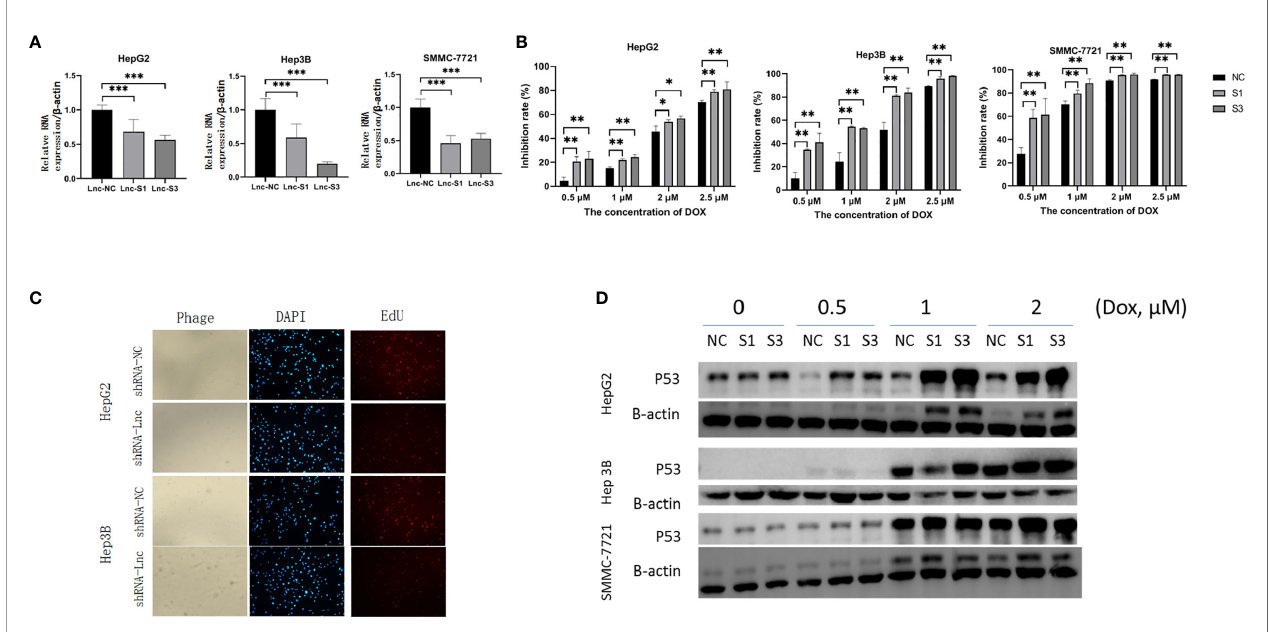
FIGURE 4 | Knockdown of lncRNA AC007639.1 inhibits the growth of hepatocellular carcinoma cells and promotes apoptosis. (A) qRT-PCR on the relative AC007639.1 expression in HepG2, Hep3B, and SMMC-7721 cells transfected with two lncRNA AC007639.1 or control siRNAs (Lnc-S1, Lnc-S3, or Lnc-NC, respectively); (B) CCK-8 assay showing inhibition of HepG2, Hep3B, and SMMC-7721 cells at different concentrations of doxorubicin after siRNAs transfection; (C) EdU analysis showing cell proliferation after transfection of scrambled shRNA (NC) or shRNA for lncRNA (shRNA-Lnc) ( fi eld of view: 200x) in HepG2 or Hep3B cells treated with 2.5 µM doxorubicin for 48 hours; (D) Western blots of p53 in the three cells lines after exposure to different concentrations of doxorubicin. NC: scrambled control siRNA or shRNA. S1, siRNA1; S3, siRNA3. *p < 0.05, **p < 0.01, ***p <